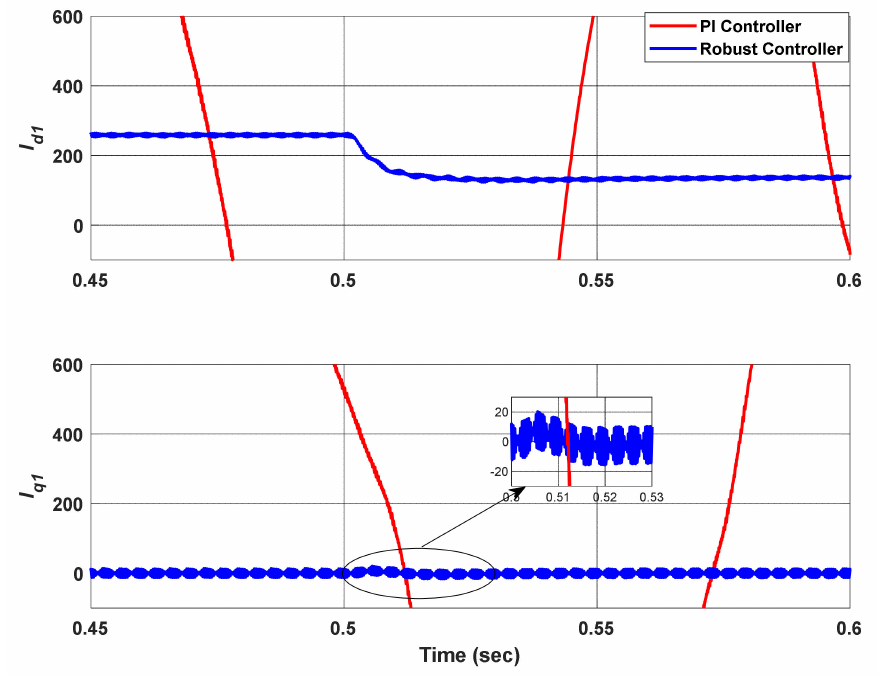
Figure 14. I d1 and I q1 for the off-nominal case for a 50% step change in active power.